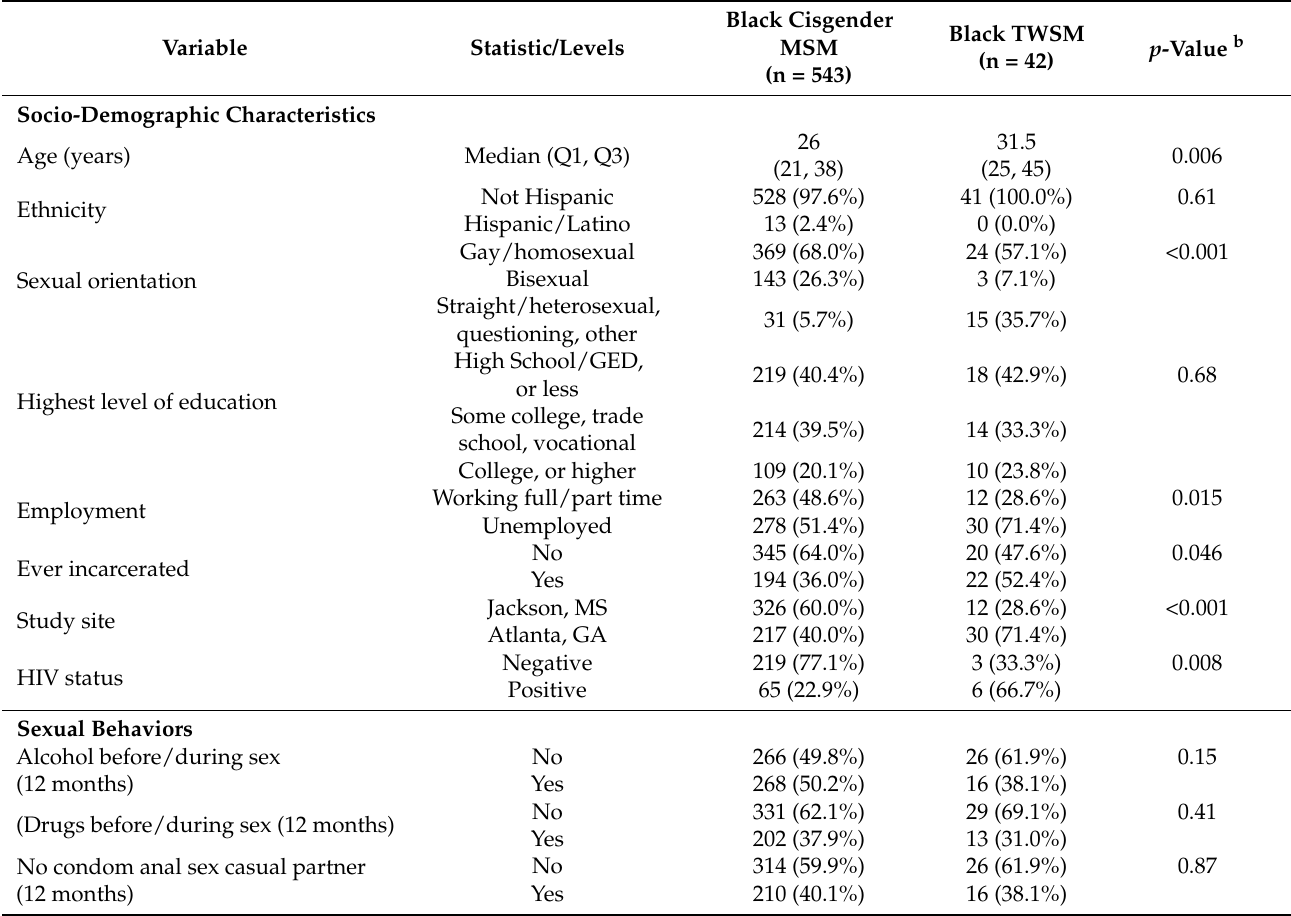
Table 1. Socio-demographic, sexual behavioral, stress, socio-cultural, and neighborhood/geographic characteristics among The MARI Study participants, by gender identity a